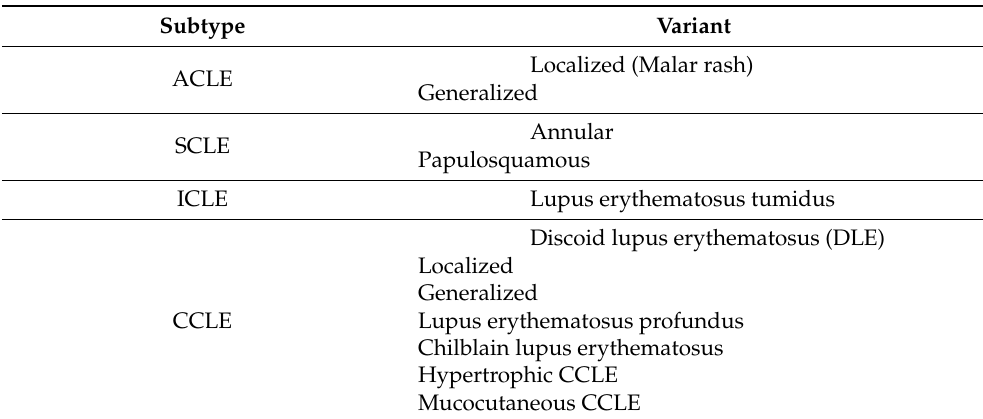
Table 1. Subtypes of CLE.